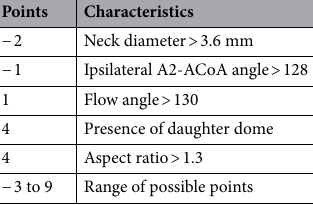
Table 4. Anterior communicating artery (ACoA) score for prediction of